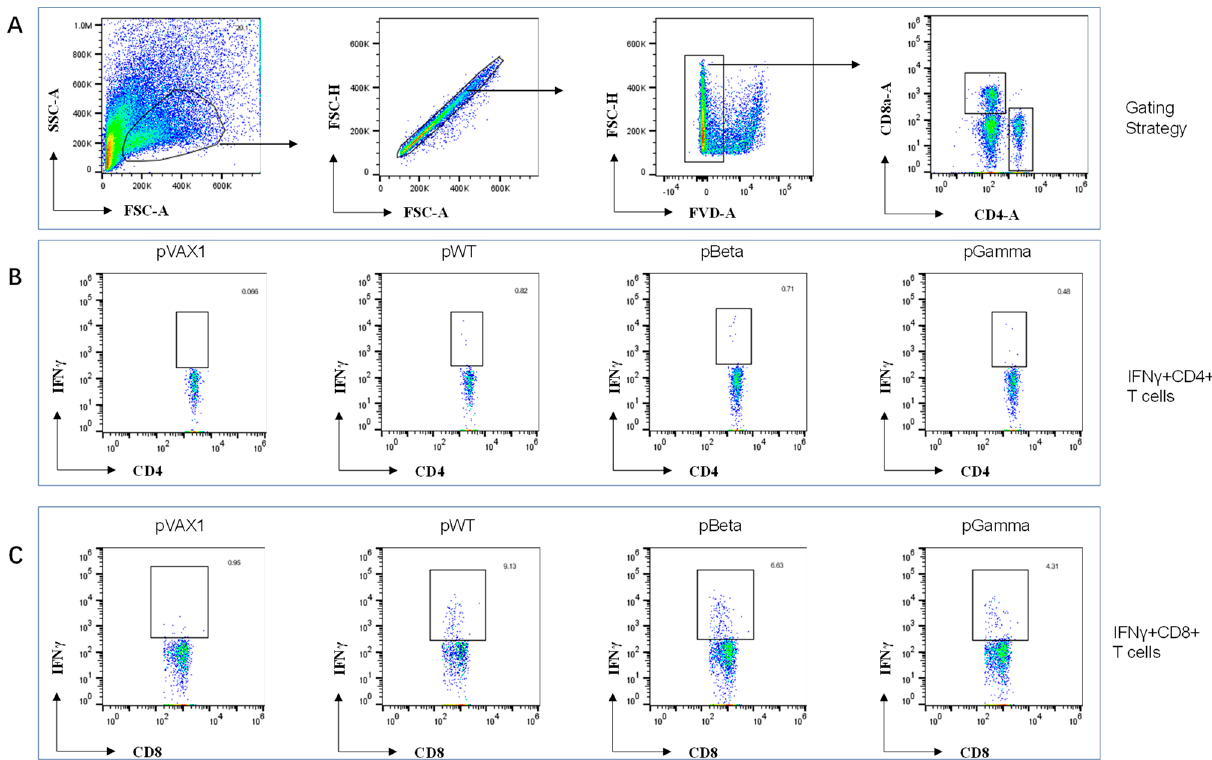
Figure 4. FACS analysis of splenocytes from mice immunized with various DNA vaccine constructs on day 21. ( A ) Gating strategy of CD4 and CD8 T cells from splenocytes, ( B ) representative data of IFN γ + CD4 + T cells, and ( C ) IFN γ + CD8 + T cells in spleens from mice immunized with the four DNA vaccine constructs: pVAX1, pWT, pBeta and